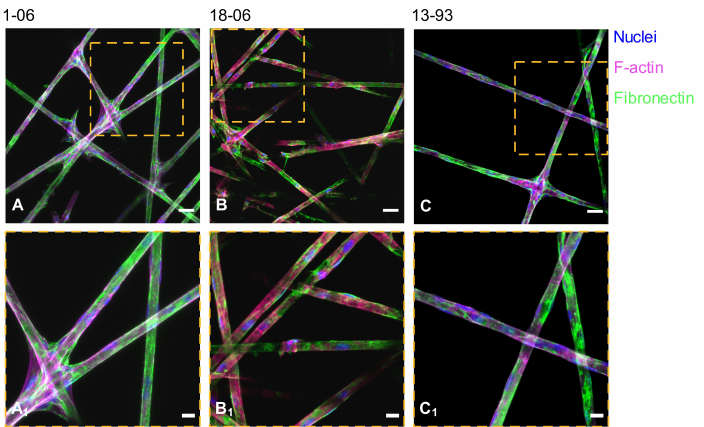
Figure 14. Representative images of the pre-osteoblast cells MC3T3-E1 adhered to the distinct bioactive glass fibres ( A – C ), depicting nuclei (blue), the structural protein actin (magenta) and the glycoprotein of the ECM fibronectin (green). ( A 1 – C 1 ) show enlarged sections of the image (magnification in the dashed orange squares). Scale bars 50µm ( upper row ) and 20µm ( lower row